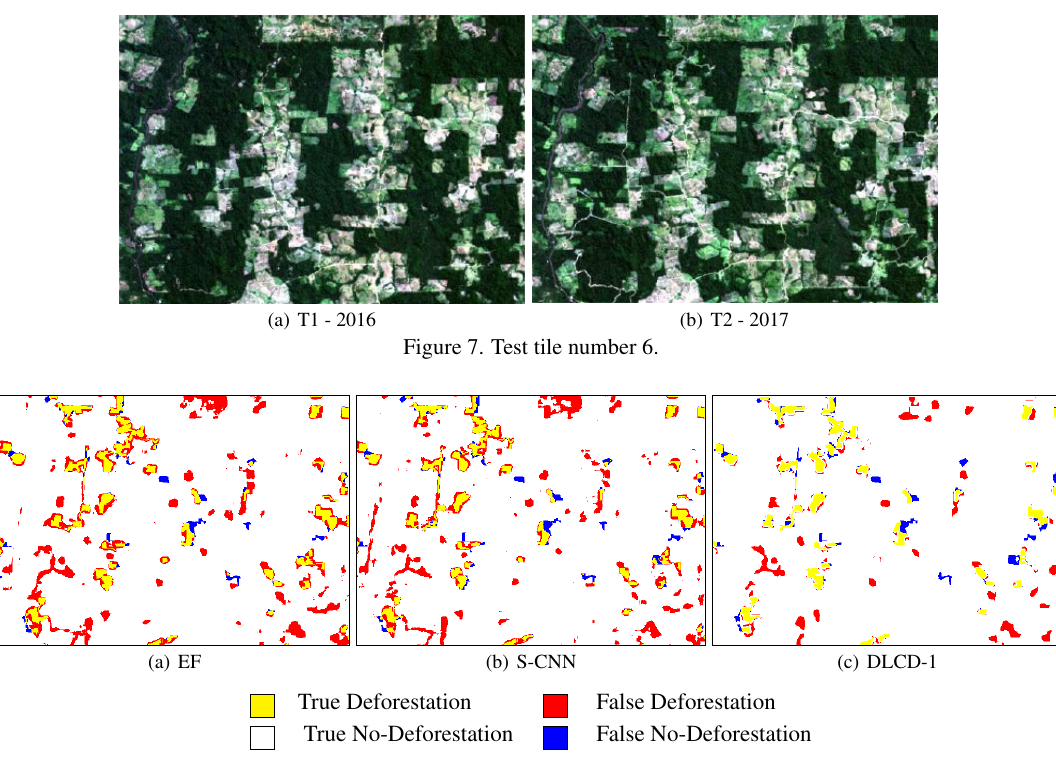
Figure 8. Change maps predicted by EF, S-CNN and DLCD-1 on test tile number 6.